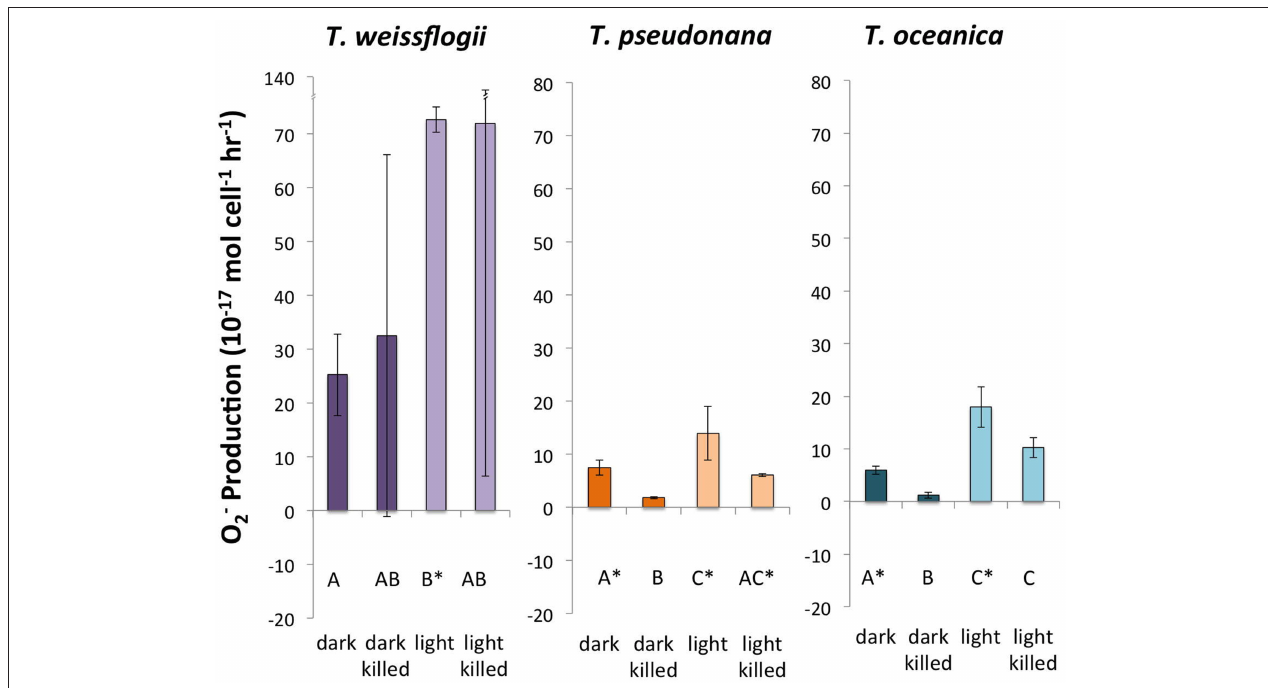
FIGURE 1 | Calculated O − 2 production rates in genus Thalassiosira . Error bars represent one standard deviation. Letters designate rates significantly different from each other within each panel. Asterisks designate P O2 − values significantly different from zero.